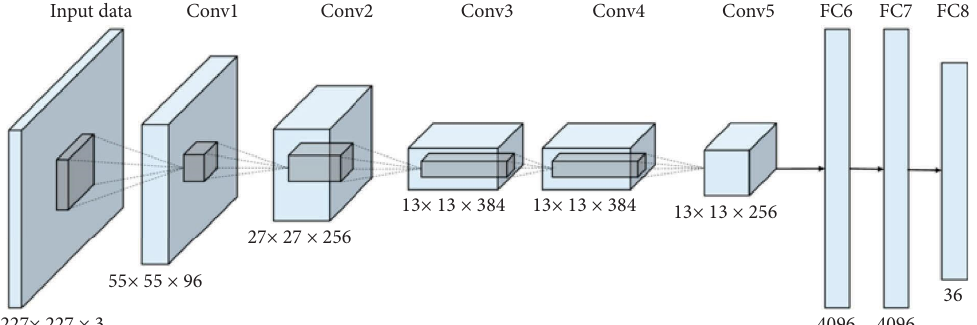
Figure 2: AlexNet architecture.